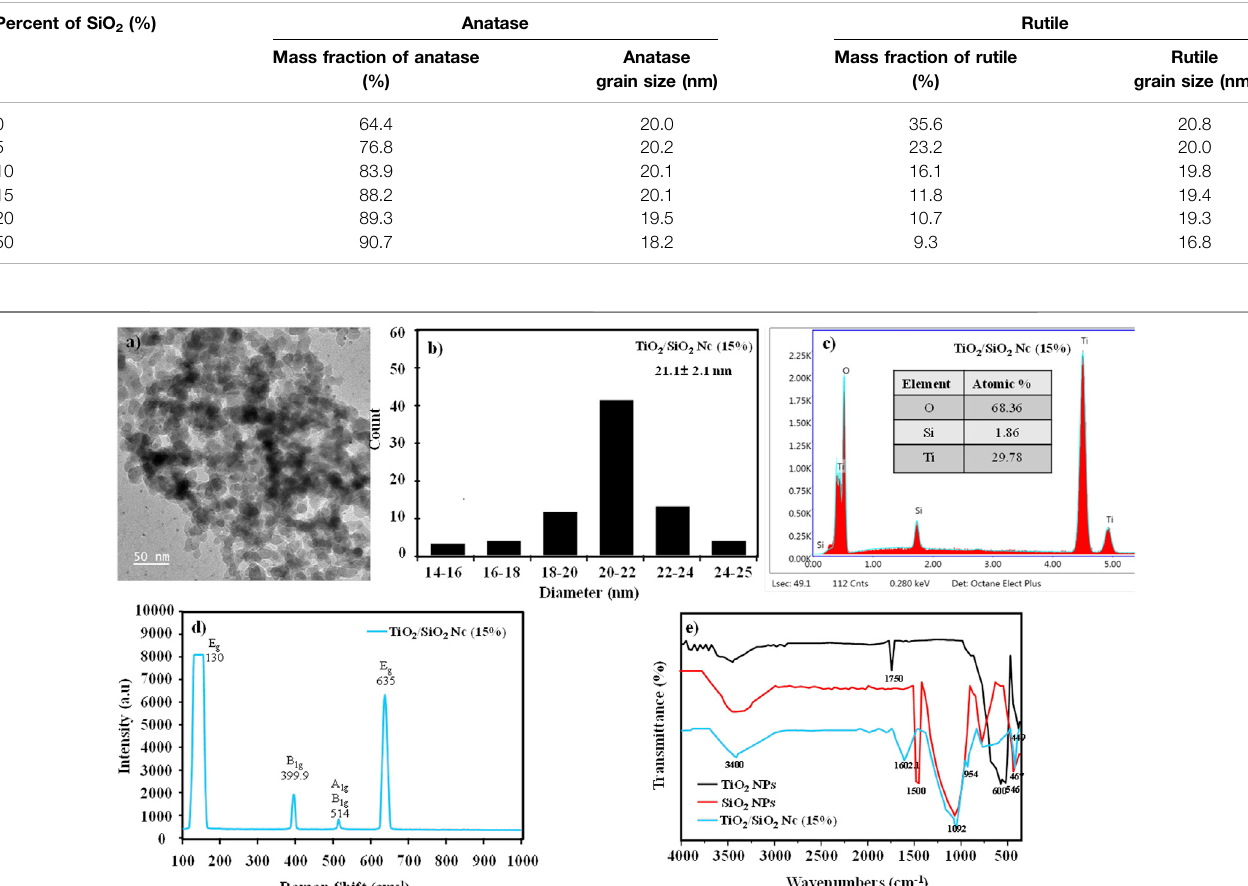
Frontiers in Chemistry |